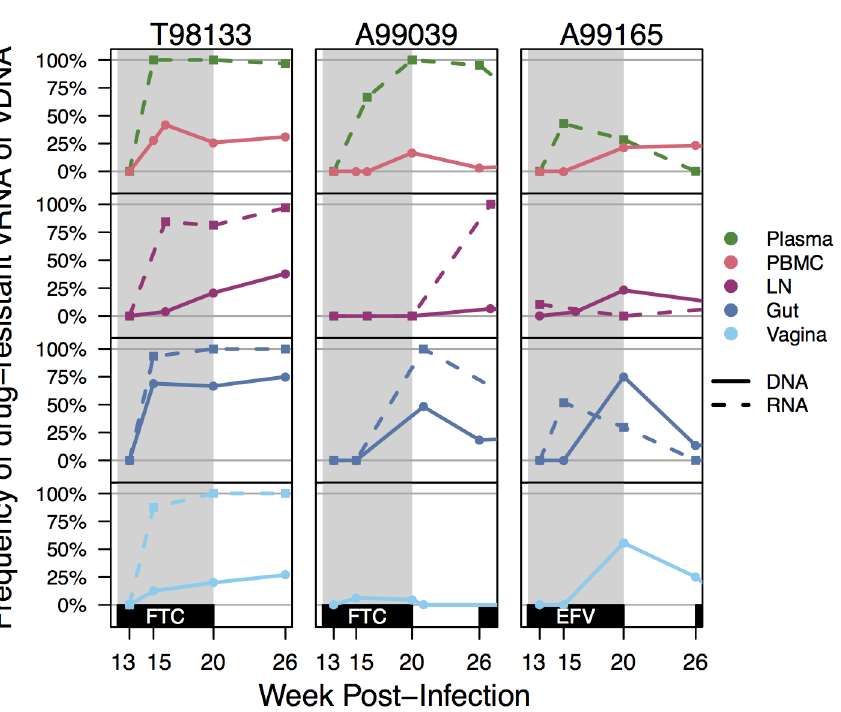
Fig 2. Drug resistance increaseover time across all compartments. Drug resistancewas definedas the proportionof vRNA (dashedlines) or vDNA (solid lines) sequenceshavingK103N and/or M184V/I within each compartment for animalsT98133, A99039, and A99165. Gray shadingindicatesthe FTC or EFV treatment periods for the